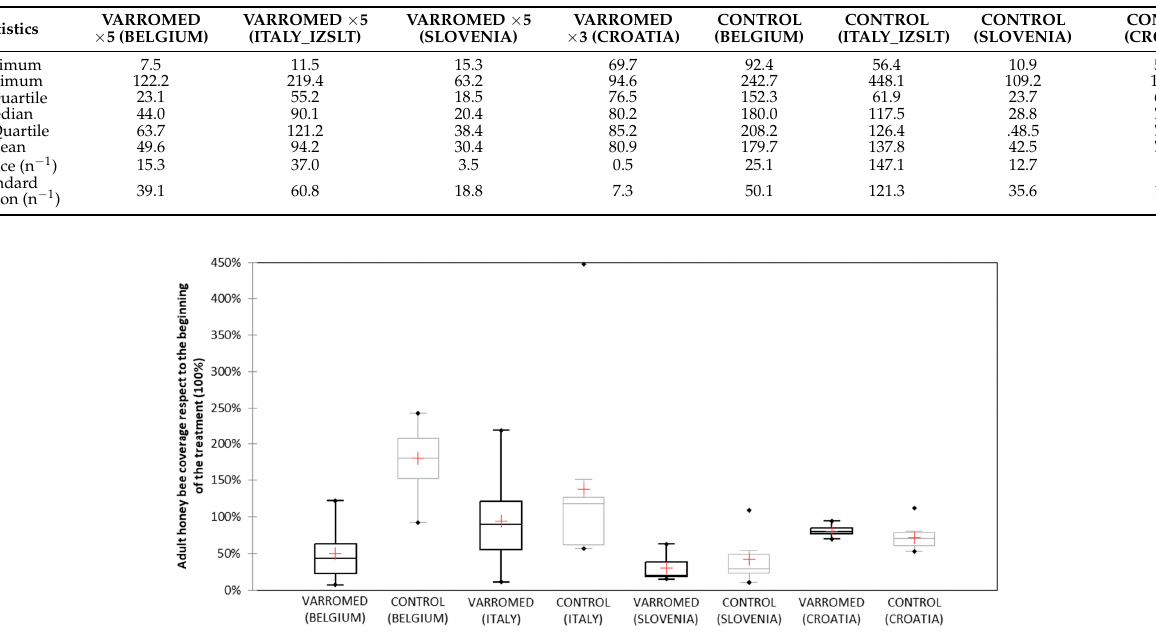
Figure 5. Box plot of adult bee coverage in all groups recorded during the summer/autumn trial compared to the beginning of the treatment (%). The horizontal line in boxes shows the median. The box shows the first and third quartile. Whiskers extend to 1.5 × interquartile range (IQR). Diamonds mark the outliers outside the 1.5 × IQR. Additionally, the pluses show mean values. Mean brood area compared to the control group decreased after VarroMed treatment in Italy and Slovenia ( − 71.1% and − 3.0%, respectively) and increased in Croatia (+24.7%), but all variations were not statistically significant (Table 4; Figure 6). Brood area was not recorded in Belgium, as bees started clustering and weather conditions were prohibitive to check brood coverage properly. Table 4. Variation of brood area in all groups recorded during the summer/autumn trial compared to the beginning of the treatment (%). Statistics